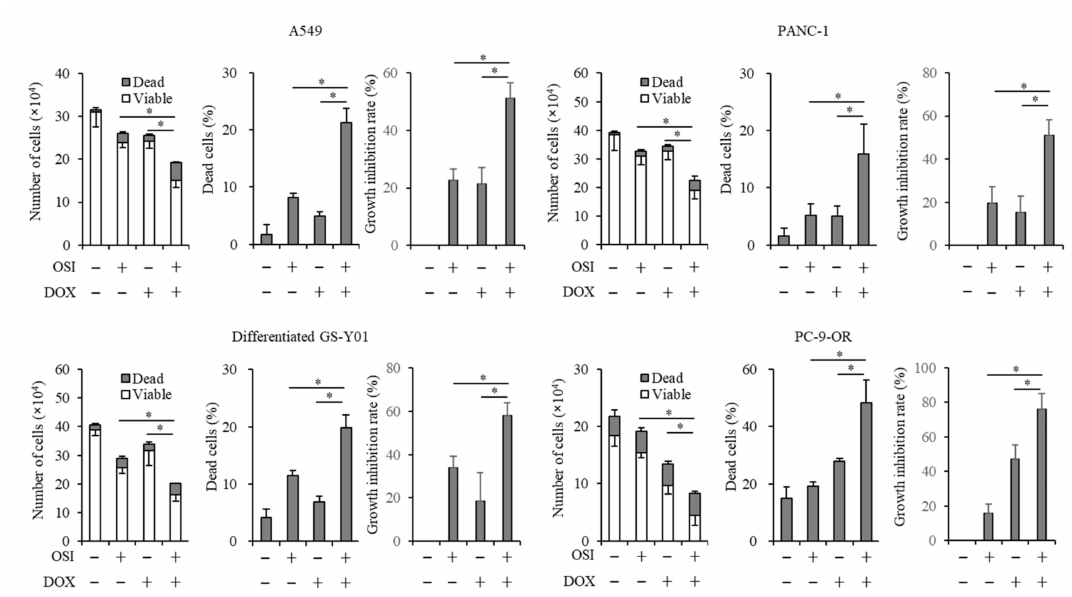
Figure 2. Doxazosin sensitizes several types of cancer cells to osimertinib. Cells were treated with / without 2 µ M osimertinib (OSI) with / without 15 µ M doxazosin (DOX) for 3 days, and the numbers of viable and dead cells ( left panels ), the percentage of dead cells ( center panels ), and the growth inhibition rate ( right panels ) were assessed. Values represent the means ± SD of triplicate samples of a representative experiment repeated with similar results. * p <